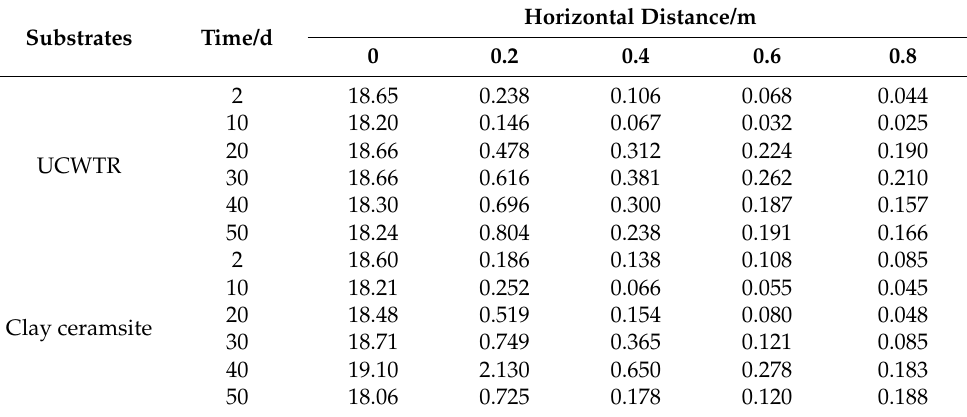
Table 7. Change in horizontal Fe concentration at 2 d, 10 d, 20 d, 30 d, 40 d, 50 d (mg/L).